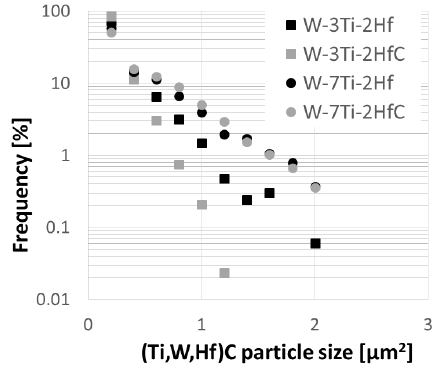
Figure 5. Frequency plot of (Ti,W,Hf)C carbide particle sizes.